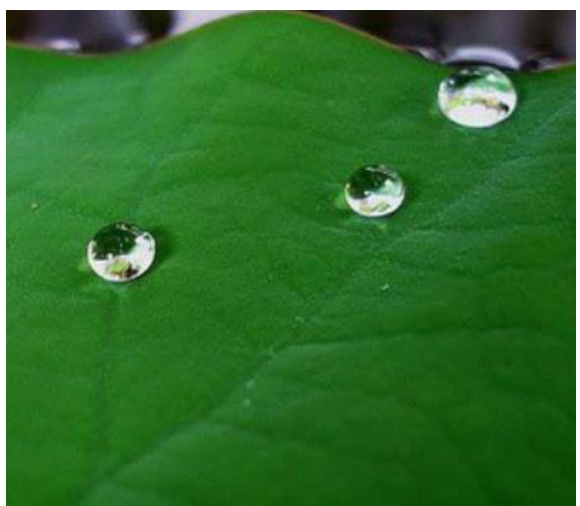
Figure 1. An optical image of water droplets resting on a water repellent Lotus leaf. The image is reproduced from Google under the terms of open access.